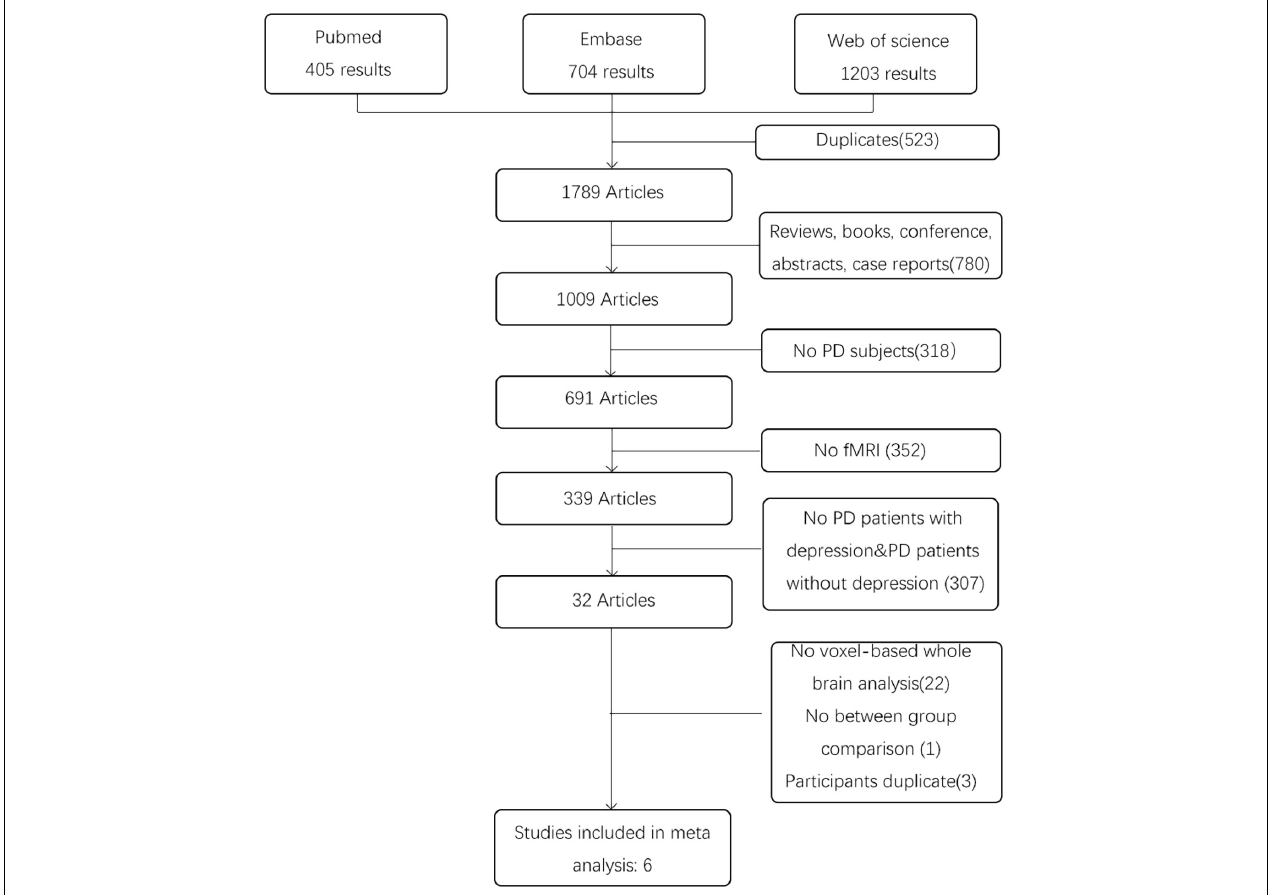
FIGURE 1 | Study selection flow chart, performed according to the PRISMA 2020